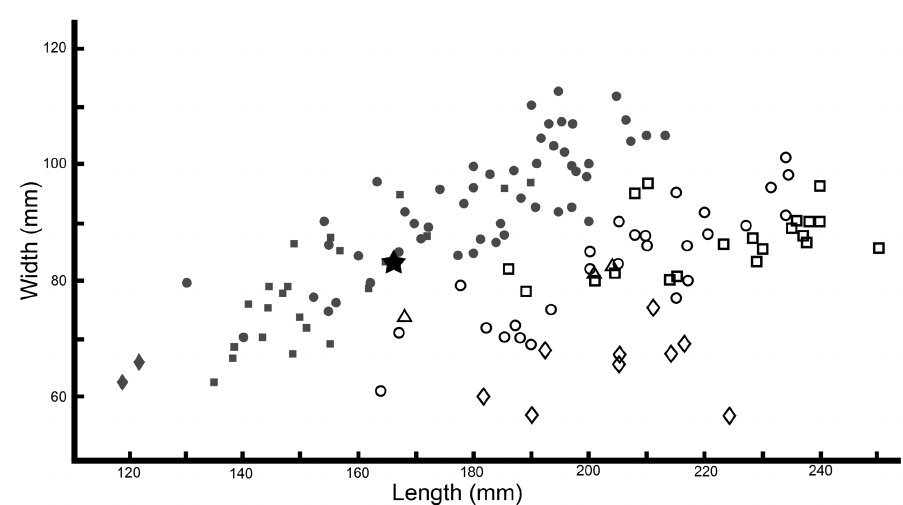
Figure 4 - Scatter diagram of late Neogene and Pleistocene Mammutidae and Gomphotheriidae m3 width and length. Note the difference between the Mammutidae cloud (gray dots) and Gomphotheriidae (open dots). Key: Sinomammut tobieni is represented by the black star; the genus Mammut is represented by the gray circles; Zygolophodon is represented by gray squares; Eozygodon is represented by gray diamonds; Tetralophodon is represented by open circles; Sinomastodon is represented by open triangles; Anancus is represented by open squares; Gomphotherium is represented by open diamonds. Data was based on Tobien (1975), Tassy and Pickford (1983), Shoshani and Tassy (1996) and Wang et al. (2014).